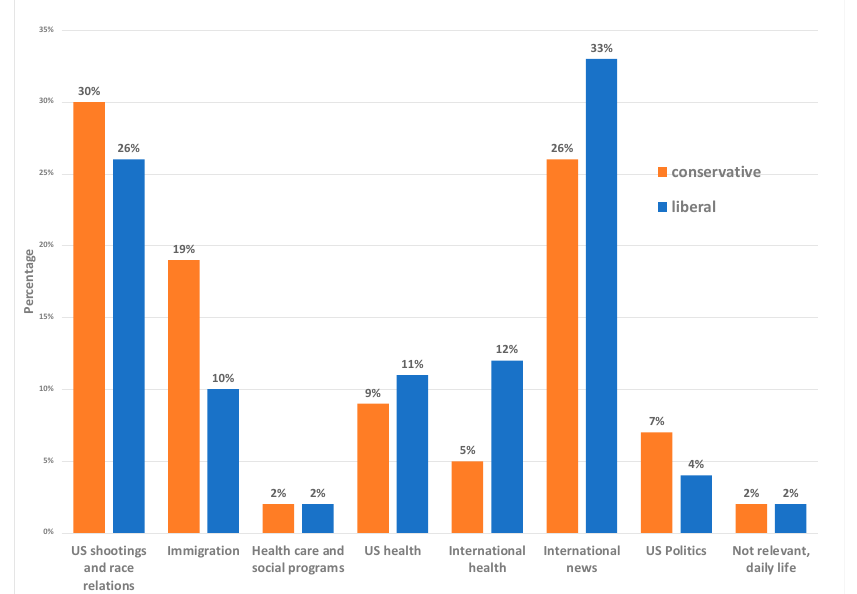
Figure 2. Percent of posts in each content analysis category by conservative and liberal news sources. Table 3. Content analysis of themes with illustrative examples by liberal and conservative news.